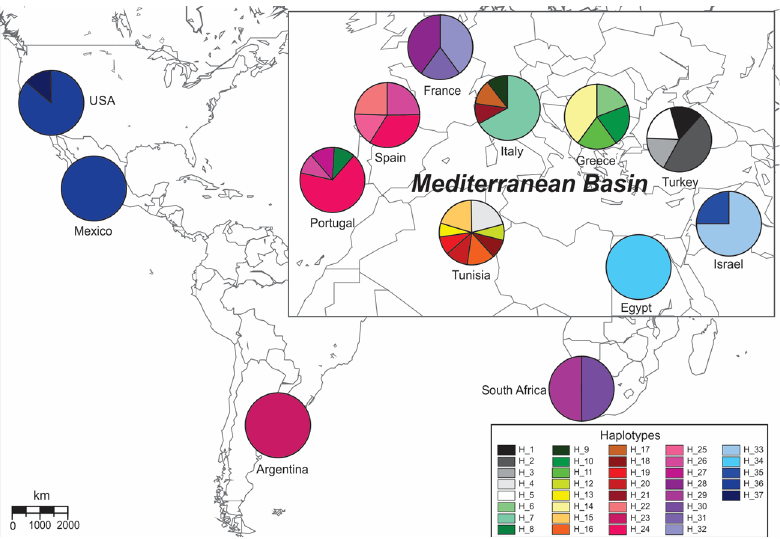
Fig 3. Geographical distribution of the CO1 haplotypes for populations of Planococcusficus collected in Europe, Africa, the Middle East, Argentina, California and Mexico.